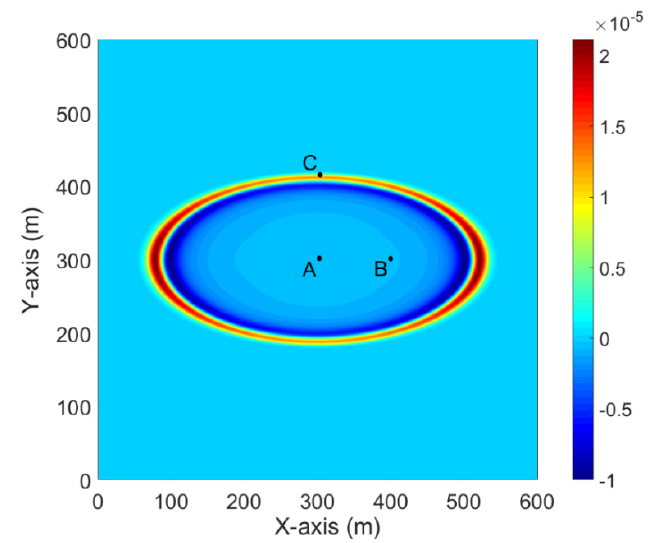
Figure 11. Magnetic field H z at time step 1000 for a medium with anisotropic behavior of electric permittivity and conductivity, and magnetic permittivity and conductivity. Cartesian axes are principal axes for these properties. Node size is 1 m for the three Cartesian directions. Points A, B, and C are used for comparison with an independent solution in the following Figure.